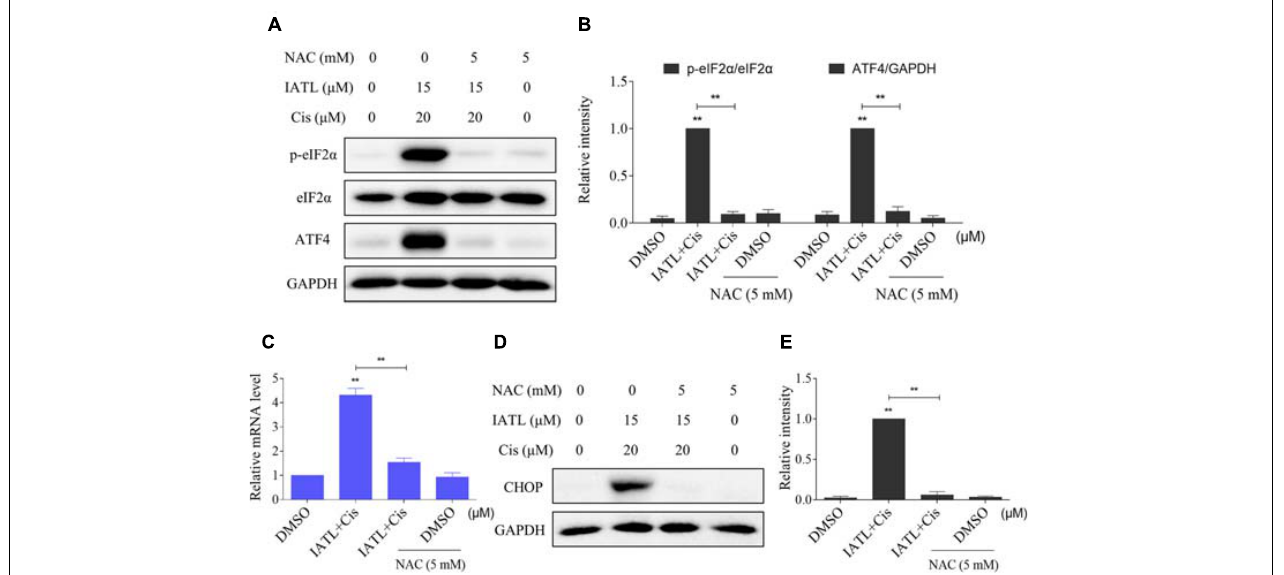
FIGURE 4 | IATL and cisplatin co-operate to activate ROS-dependent ER stress. (A,B) DU145 cells were preincubated with NAC (5 mM) for 2 h before exposure to the combination of IATL (15 µ M) and cisplatin (20 µ M); the expression of p-eIF2 α and ATF4 was measured by Western blot. (C) DU145 cells were preincubated with NAC (5 mM) for 2 h; the mRNA level of CHOP was determined by qRT-PCR after being treated with IATL (15 µ M) and cisplatin (20 µ M) combination for 6 h. (D,E) DU145 cells were preincubated with NAC (5 mM) for 2 h before exposure to the combination of IATL (15 µ M) and cisplatin (20 µ M) for 12 h; the expression of CHOP was measured by Western blot. ** p < 0.01.